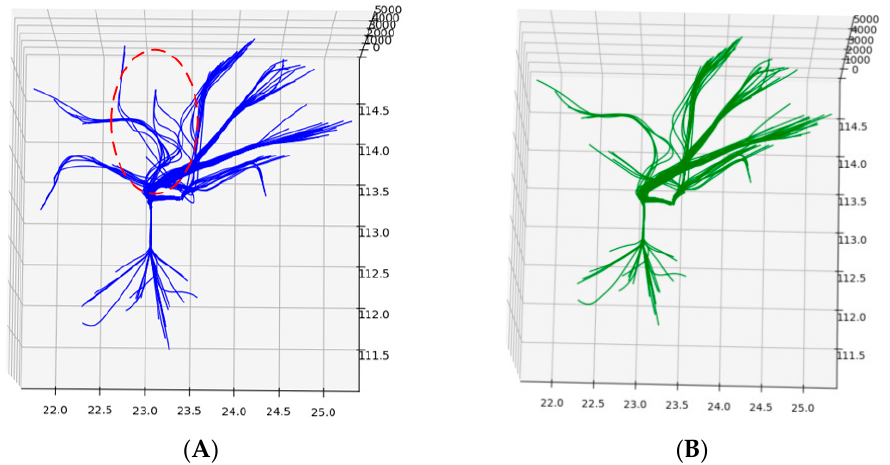
Figure 11. High noise area and denoised sample set. ( A ) Sample set before reconstruction. ( B ) Sample set after reconstruction.